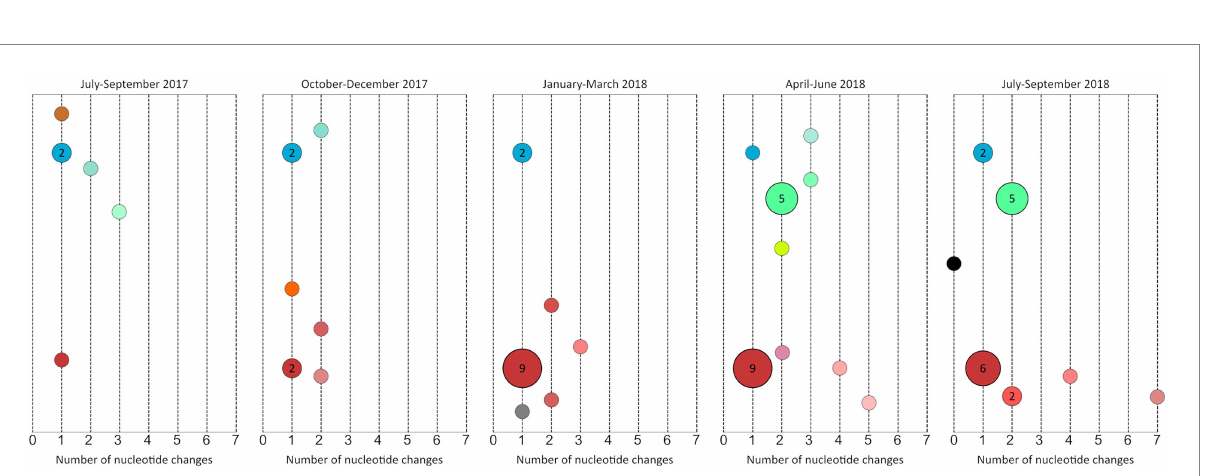
FIGURE 4 Quarterly representation of the variants detected using the concatenated genes of the scheme proposed in this study (4,042 bp) from July 2017 to September 2018 ( n = 68). The number inside the circles corresponds to the number of samples included in each node. If no number is represented, it corresponds to one sample. The black circle corresponds to the L2b variant reported in Netherlands; red-tone circles correspond to L2b- ompA L2 variants; blue-tone circles correspond to L2bV1 variants and green-tone circles correspond to L2bV7 variants. The x-axis represents the number of nucleotide changes in each variant with respect to L2b/UCH-1